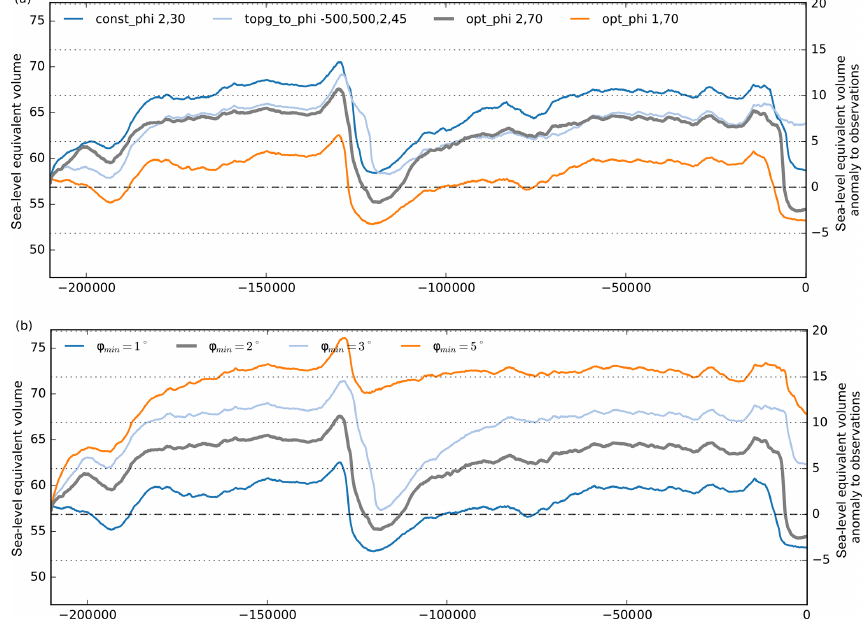
Figure 15. Ice volume histories over two glacial cycles for different parameterizations of till friction angle. (a) For a spatially uniform φ (with 30 ◦ in grounded ice and 2 ◦ elsewhere; blue) and a till friction angle that is parameterized as function of the bed topography (light blue), the simulated ice volumes are generally larger than for the reference (grey), where φ is a result of the simple inversion technique. In those three cases the same minimal φ min was used. For a smaller φ min = 1 ◦ we find generally smaller ice volumes. (b) The choice of φ min has strong influence on the reconstructed ice volume, with high till friction angles leading to more friction and hence thicker ice sheets. Within the plausible range from 1.0–5.0 ◦ we find up to 18mSLE difference in simulated ice volume above